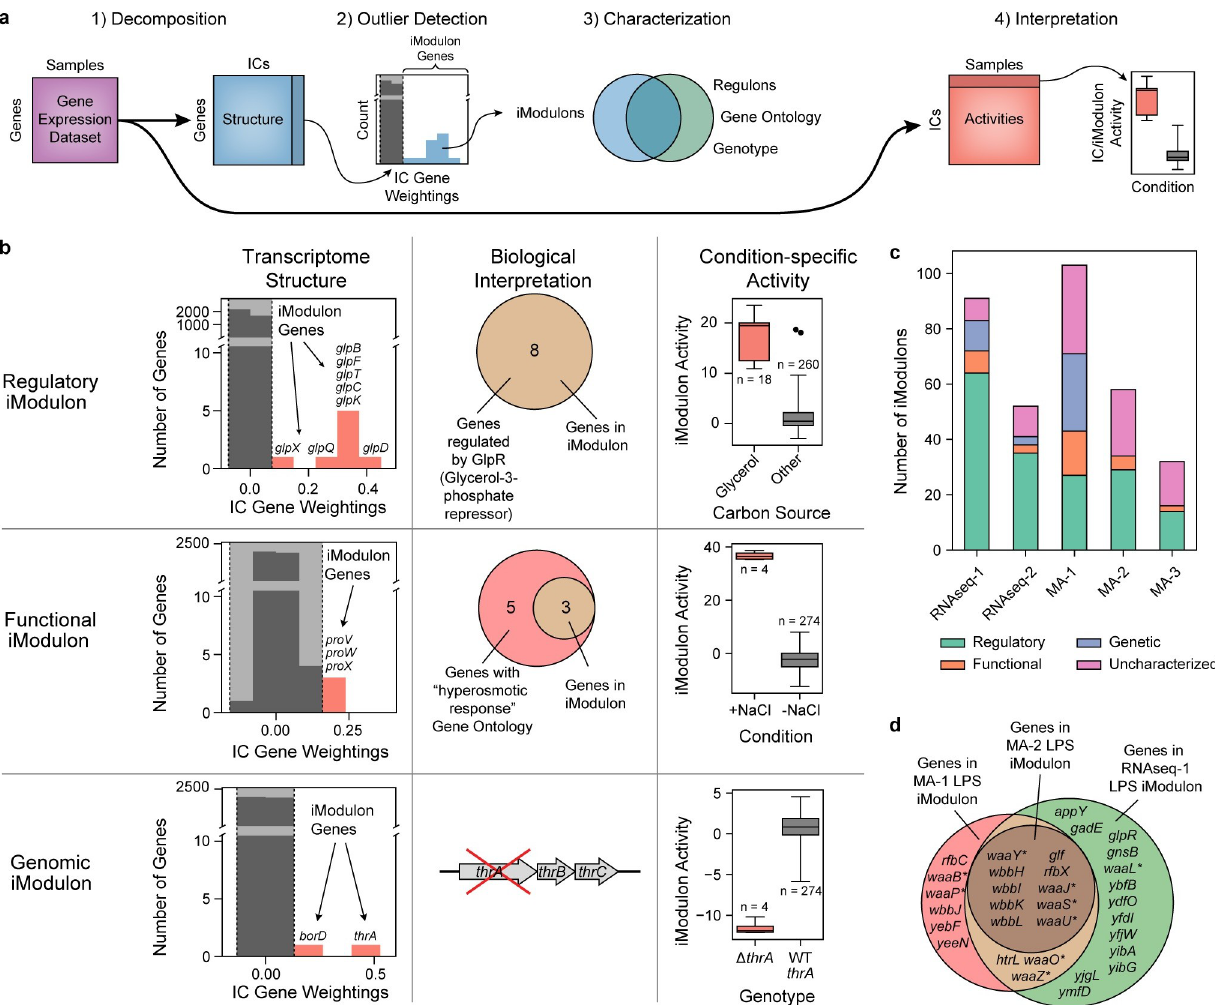
Fig 1. Characterization of iModulons derived from five independent gene expression datasets. (A) Schematic illustration of the workflow applied to each data set. (B) Descriptions of the three classes of characterized iModulons. The first column contains histograms illustrating the distribution of gene weightings in each of three independent components (ICs) from the RNAseq-1 dataset. Genes outside of a threshold (in red) belong to an “iModulon”. The second column illustrates the biological interpretation of the iModulon types. iModulons are characterized by comparing their genes with known regulons, ontological annotations, and genotypes. The third column displays the ICA-computed activity levels for the selected ICs across all 278 conditions in the RNAseq-1 dataset. (C) Bar chart describing the four types of iModulons computed from each of the five gene expression datasets. (D) Comparison of three Functional iModulons, each derived from decomposition of a different dataset. Asterisks indicate genes annotated with the GO term “lipopolysaccharide core region biosynthetic